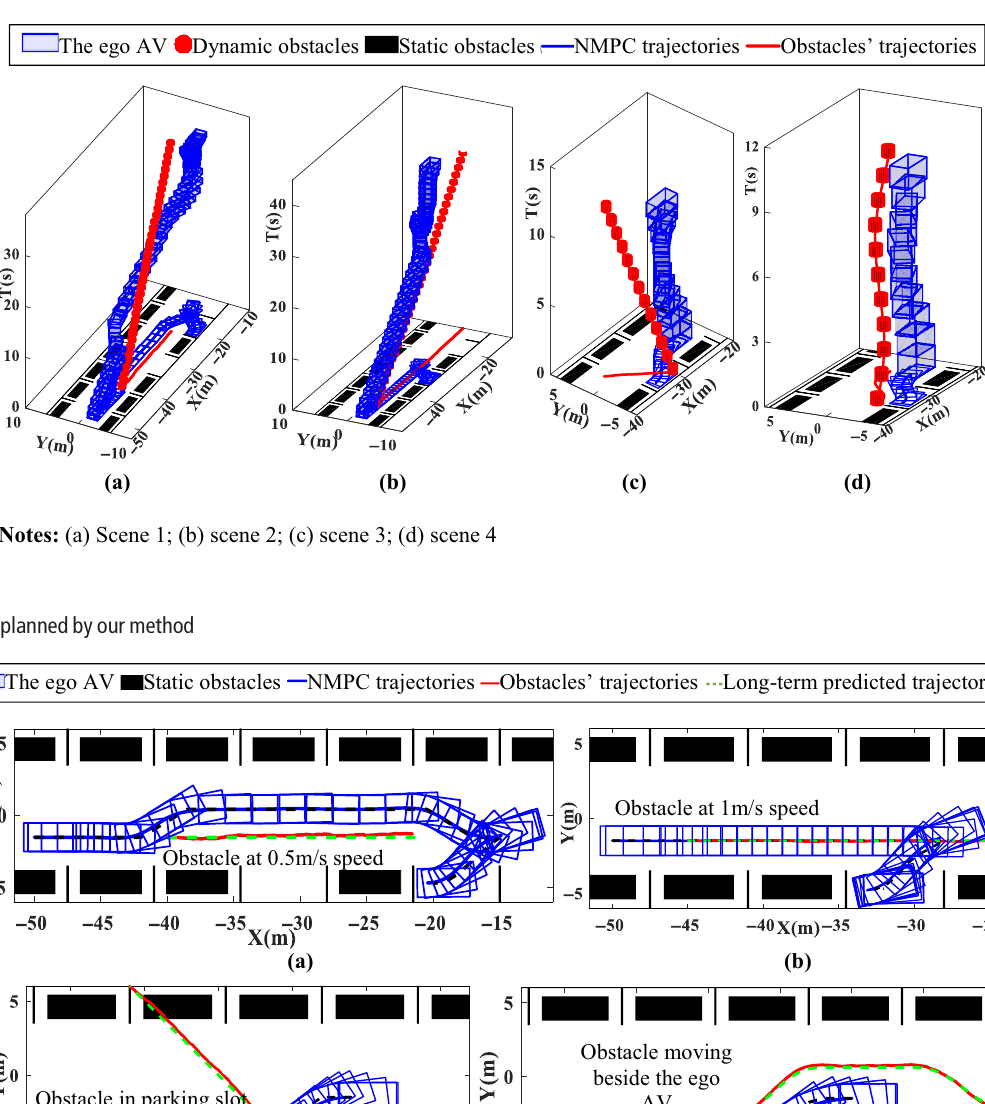
Figure 7 Spatio-temporal trajectory